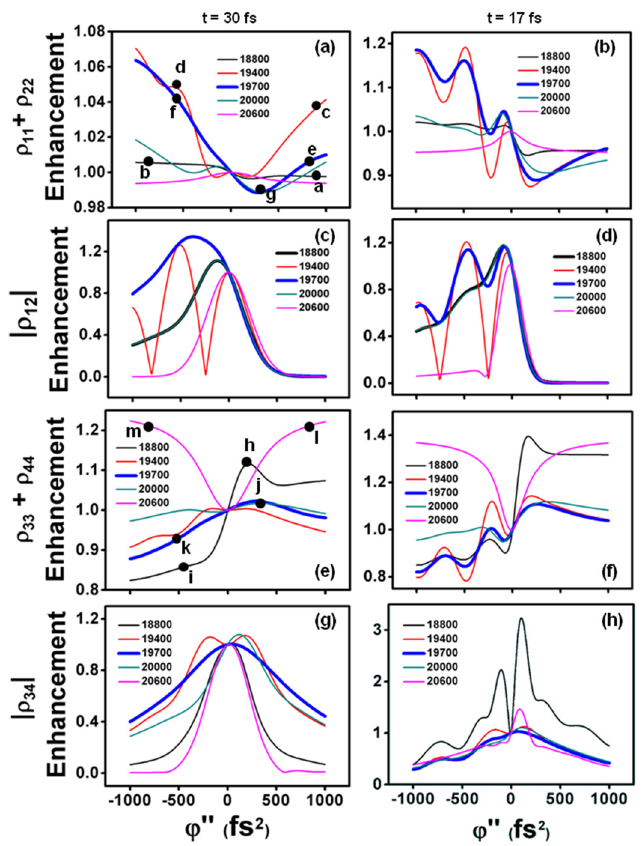
Figure 5. Enhancement/suppression factors of ( a , b ) population in the ground state; ( c , d ) vibrational coherence in the ground state; ( e , f ) population in the upper state; and ( g , h ) vibrational coherence in the upper state. The right hand panels are for a laser pulse of 30 fs and the right hand panels for 17 fs, as indicated. The colored lines represent the different excitation frequencies: 18,800 cm − 1 (black line), 19,400 cm − 1 (red line), 19,700 cm − 1 (blue line), 20,000 cm − 1 (dark cyan line), and 20,600 cm − 1 (magenta line). The electronic dephasing time is 100 fs for all cases. A bold (blue) line has been chosen for the excitation wavenumber of 19,700 cm − 1 , in order to clarify the comparisons with Figure 7.